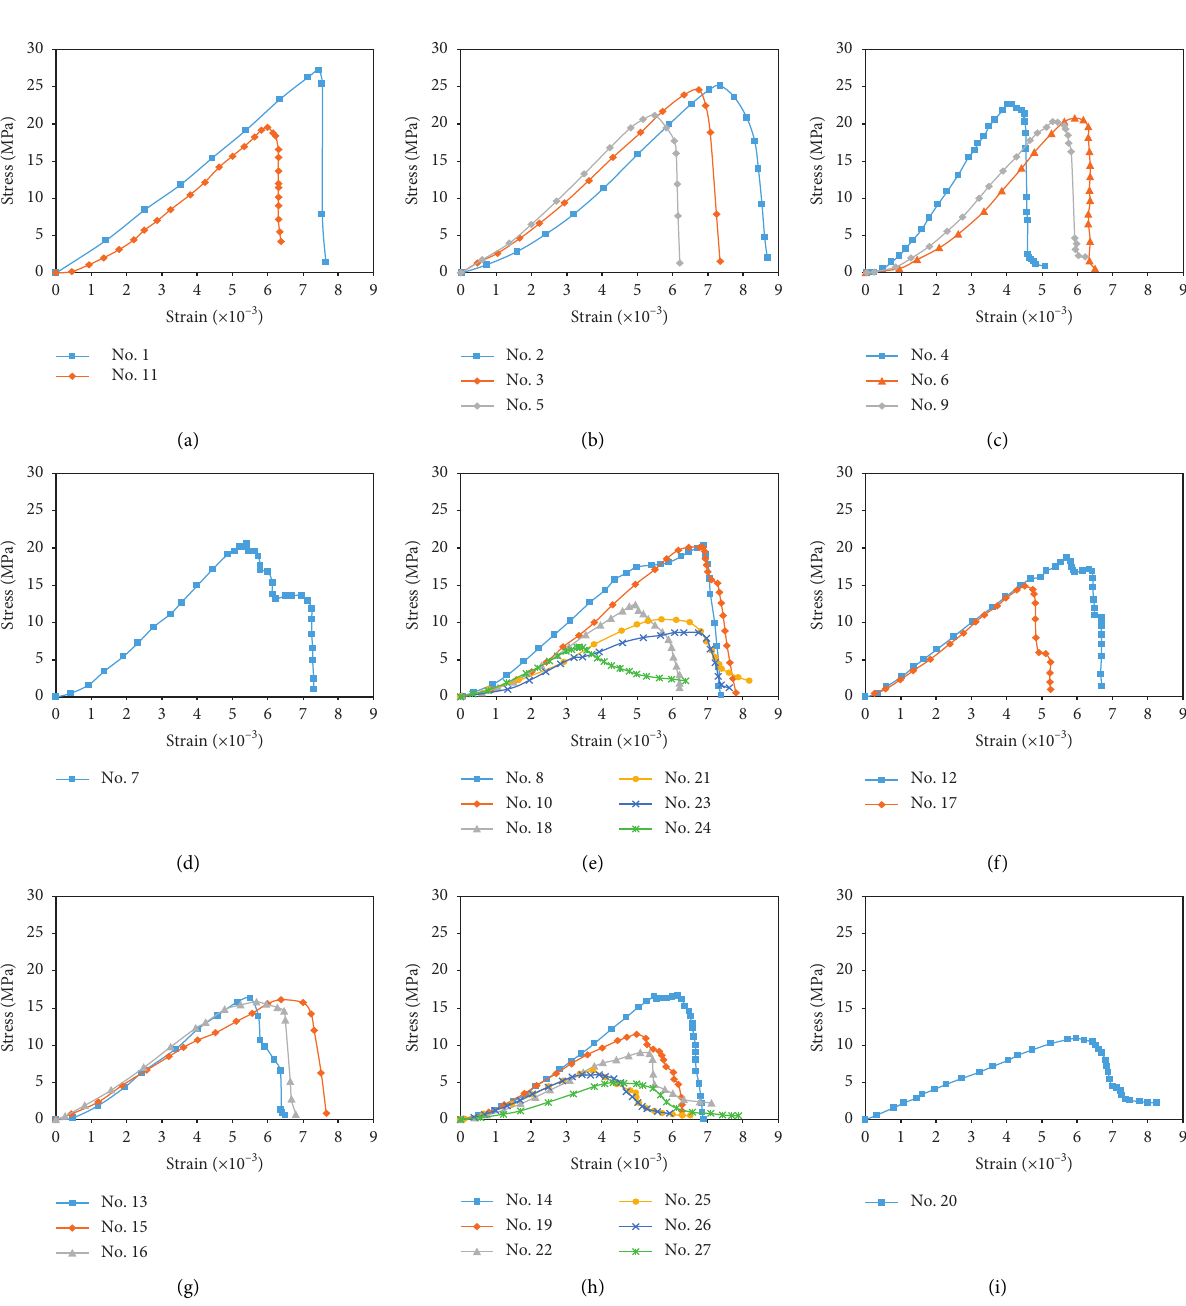
Figure 2: The stress-strain curves of 27 coal specimens grouped based on coal mines where they are taken: (a) Zhaogu coal mine; (b) Tangshan coal mine; (c) Mentougou coal mine; (d) Sanjiaohe coal mine; (e) Pingdingshan coal mine; (f) Zhangcun coal mine; (g) Qianqiu coal mine; (h) Chengjiao coal mine; (i) Jixi coal